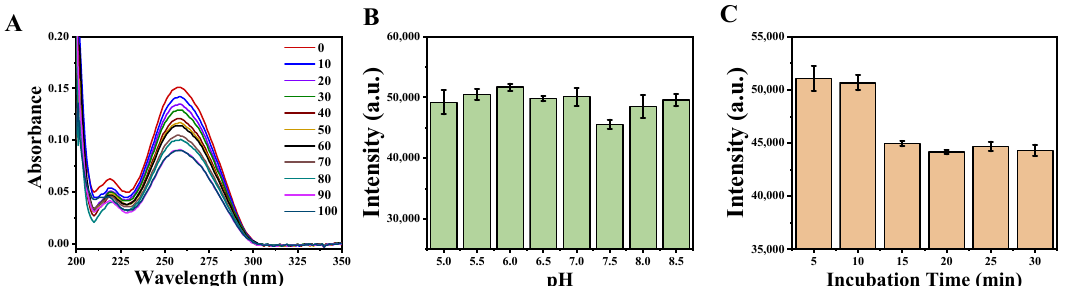
Figure 4. Optimization assay conditions: ( A ) Ultraviolet-visible (UV-vis) spectra of the various mass ratio of biotinylated aptamer and avidin-coated magnetic beads. ( B ) Phosphorescence intensity of the sensor upon detection of Cd 2+ at different pH conditions. ( C ) Phosphorescence intensity at various incubation times for sensor upon detection of Cd 2+ .